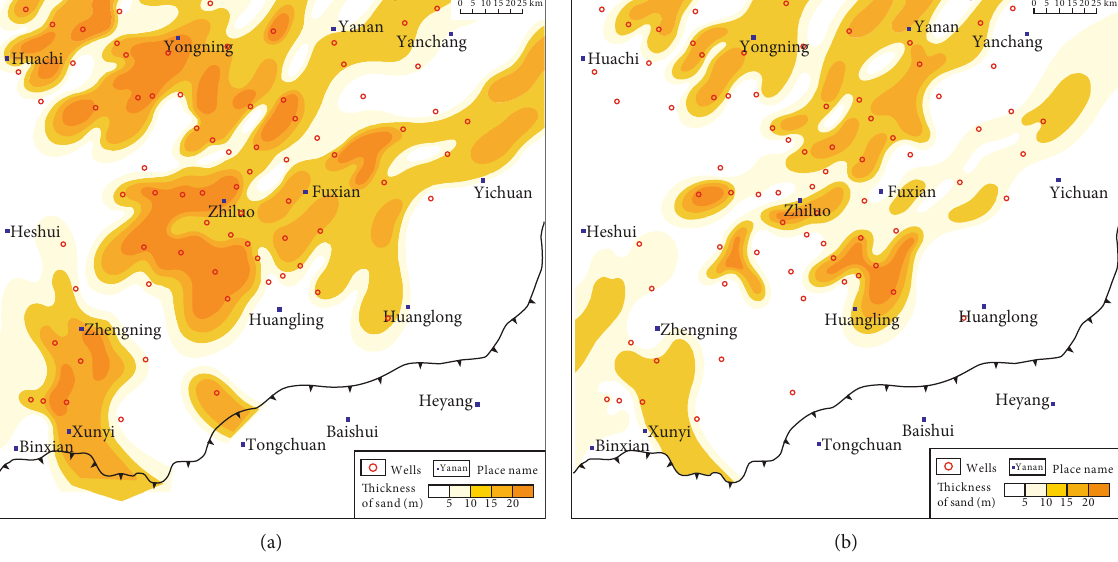
oil layer; (b) thickness of sand body, Chang 7